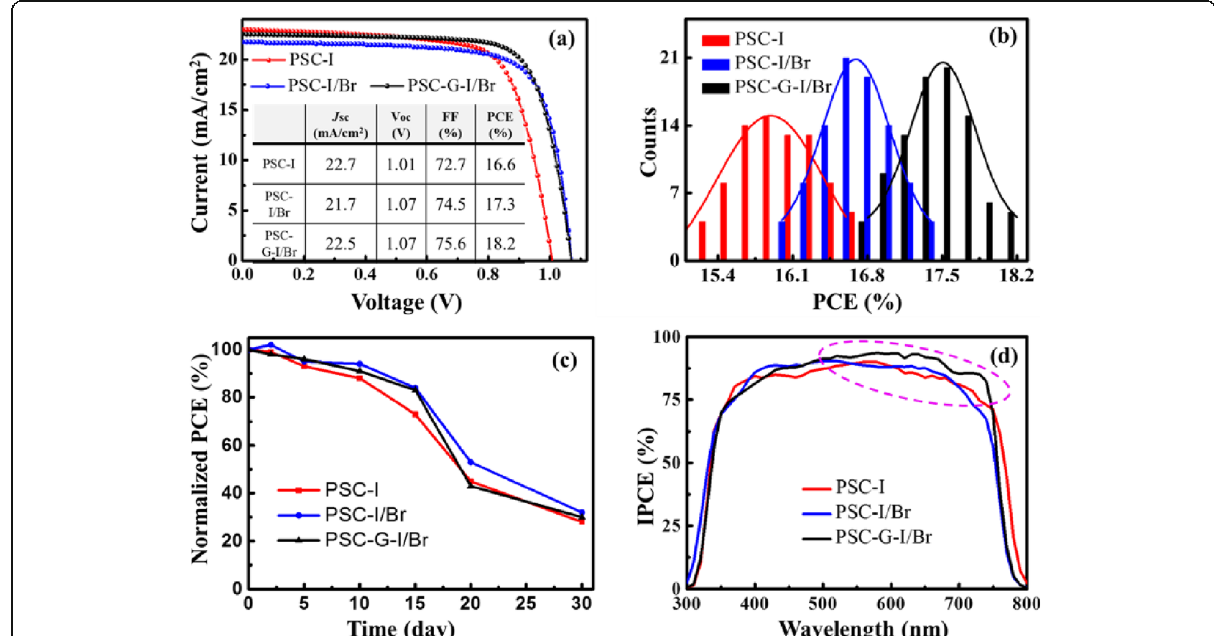
Fig. 4 a J-V curves of the PSCs, the insert is their parameter results. b The PCE histograms of PSC devices. c PCE evolution of unencapsulated devices under dark storage in a dry box (25 °C, RH 30%). d IPCE curves of the